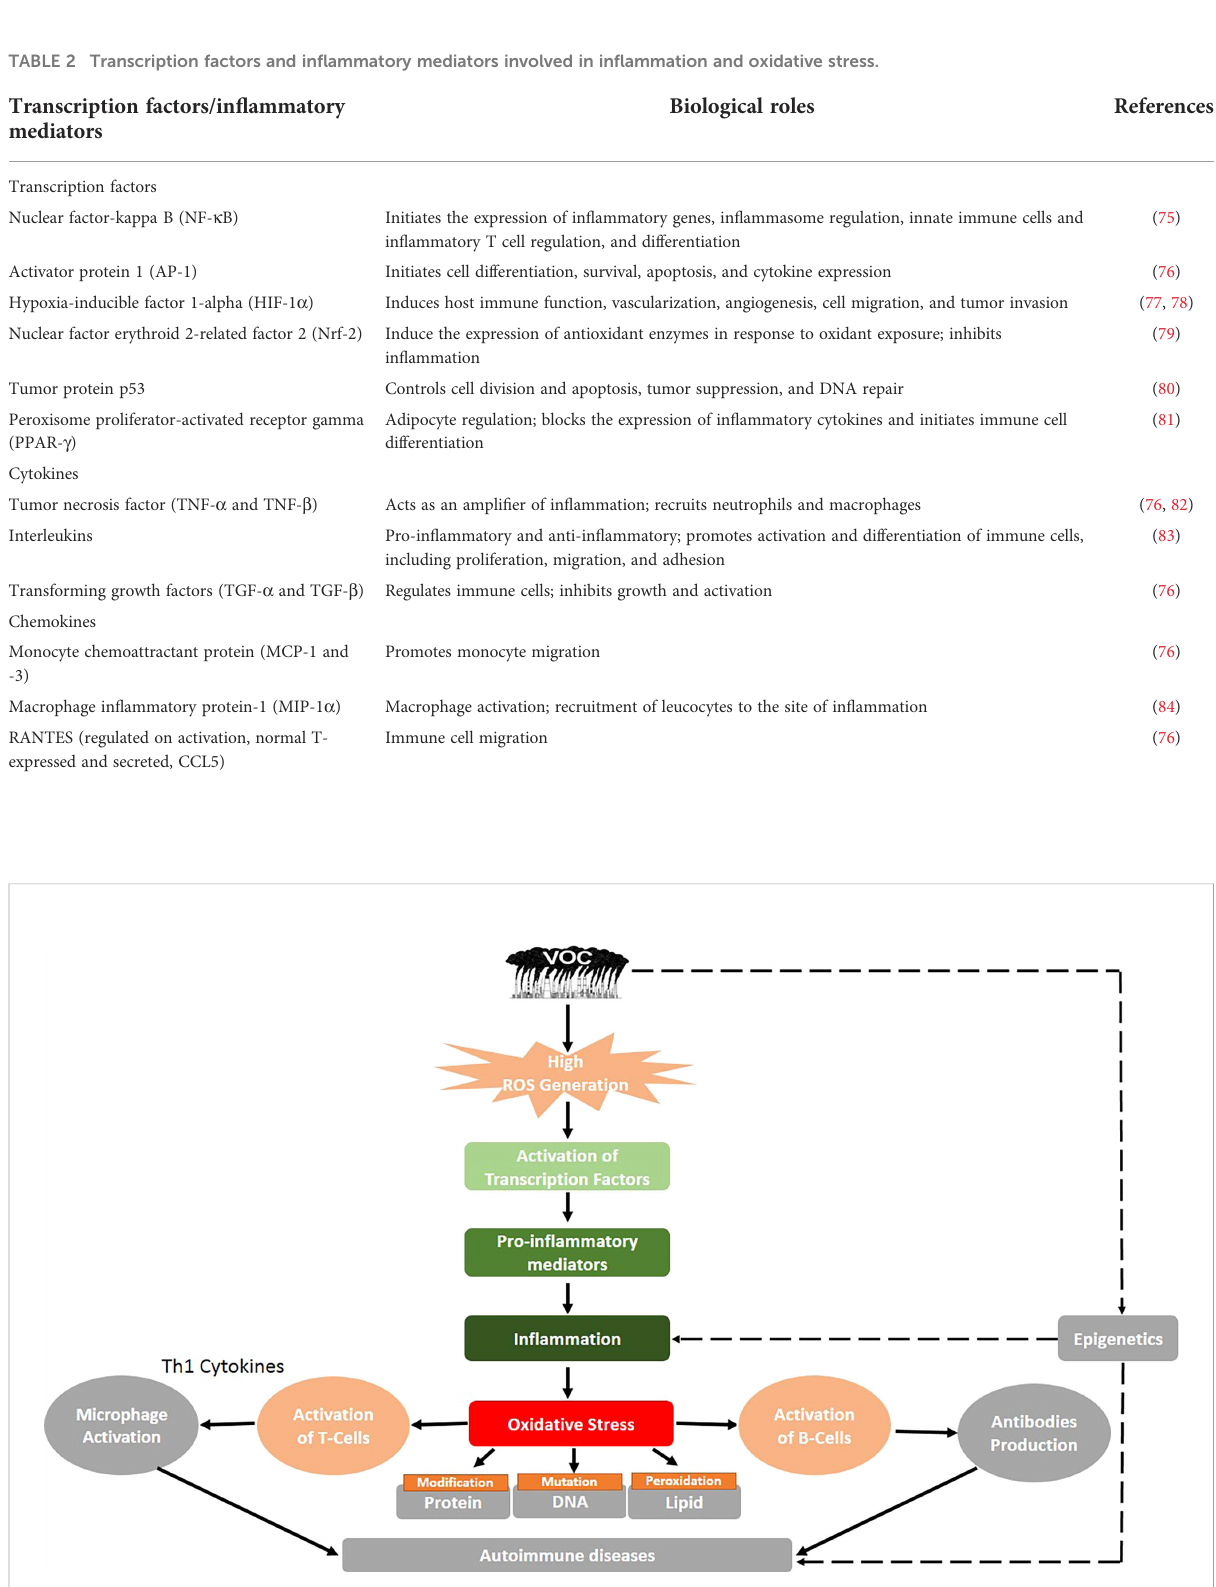
FIGURE 1 Proposed mechanism of volatile organic compound-induced in fl ammatory response and autoimmune diseases. Black solid arrows represent known pathways, and the black dashed arrows show an assumed mechanism, thus requiring future